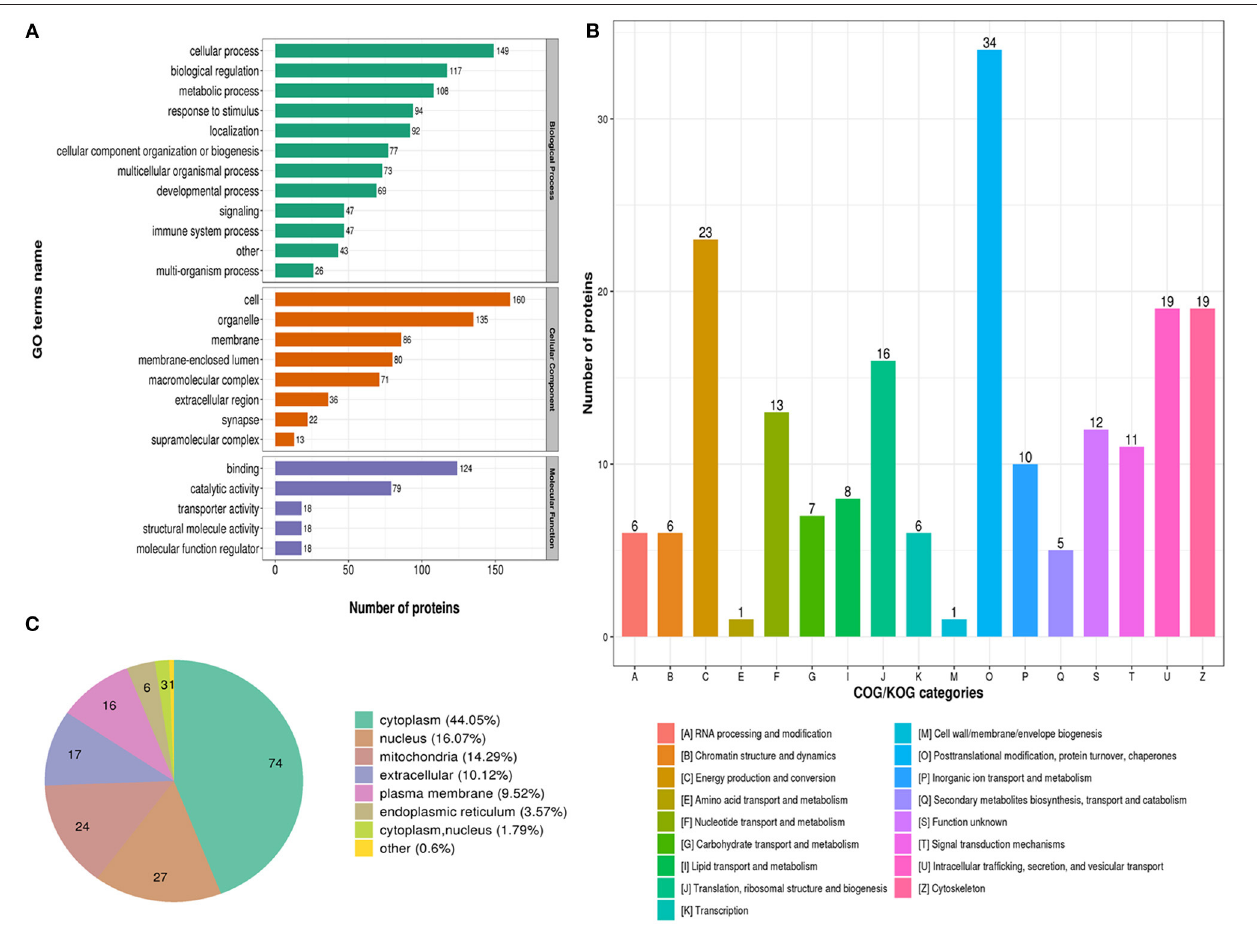
FIGURE 2 | Characterization of identified regulated acetylated proteins in glioma-associated seizure. (A) The classification of regulated acetylated proteins in biological process, cell components, and molecular function. (B) The categories of regulated acetylated proteins in COG/KOG categories. (C) The distribution of regulated acetylated proteins in subcellular